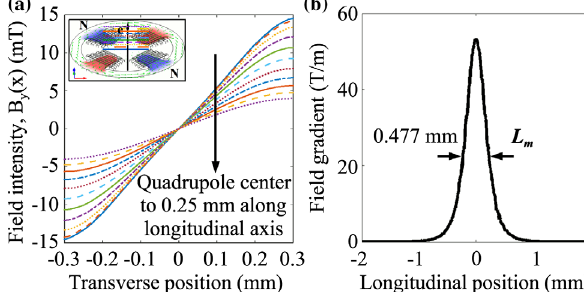
FIG. 5. FEM simulation of the prototype MEMS quadrupole. (a) Transverse quadrupole field intensity plotted across the x-axis ð x Þ between the pole tips) at longitudinal positions from the ( B y quadrupole center to 0.25 mm above the center. Note that the x-axis does not intersect the poles. (b) Field gradient ( dB plotted down the electromagnet transverse center along the longitudinal (z) axis for I ¼ 1 A.